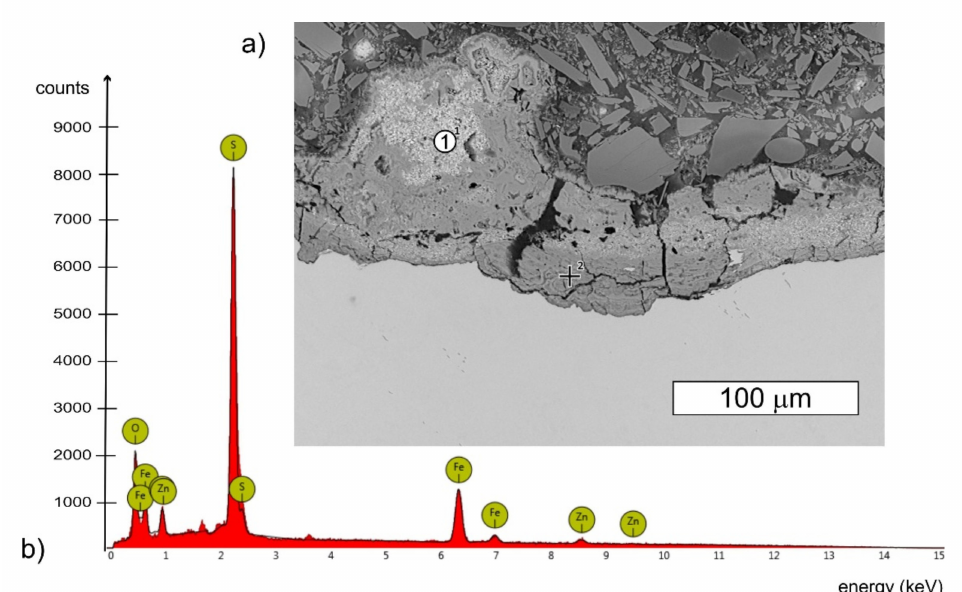
Figure 17. ( a ) SEM image of the deposit observed on the cross-section of the S1 bolt thread surface, BSD ( b ) Characteristic X-ray spectrum obtained for point 1 presented in Figure 17a,